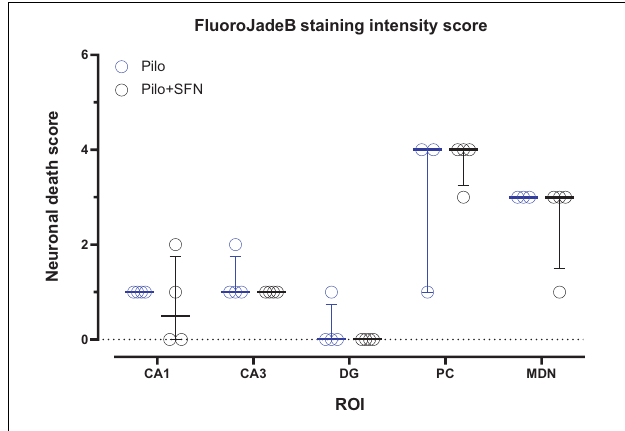
FIGURE 3 | SFN pretreatment had no impact on the neuronal death measured 24 h after the induction of SE (multiple unpaired Mann–Whitney tests comparing Pilo and Pilo + SFN group). All values are reported as median ± interquartile